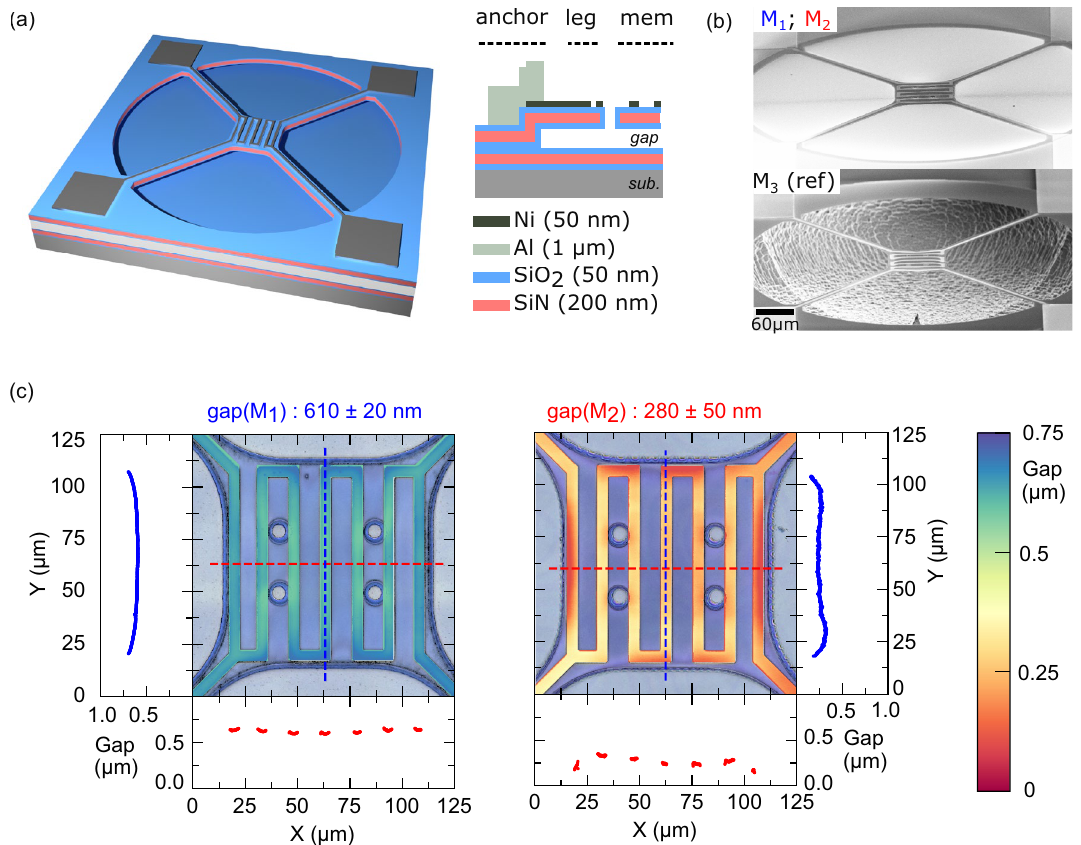
Figure 1. ( a ) 3D and cross section schematic view of the suspended membranes. ( b ) SEM image of a sample with a sub-micron gap such as M1 or M2, and the reference membrane with the substrate etched (M3). ( c ) Superposition of optical microscope images and laser interferometry gap measurements for samples M1 and M2. Gap values measured on the Ni heater are shown by the colormap and also plotted along the horizontal (red) and vertical (blue) dash lines on both